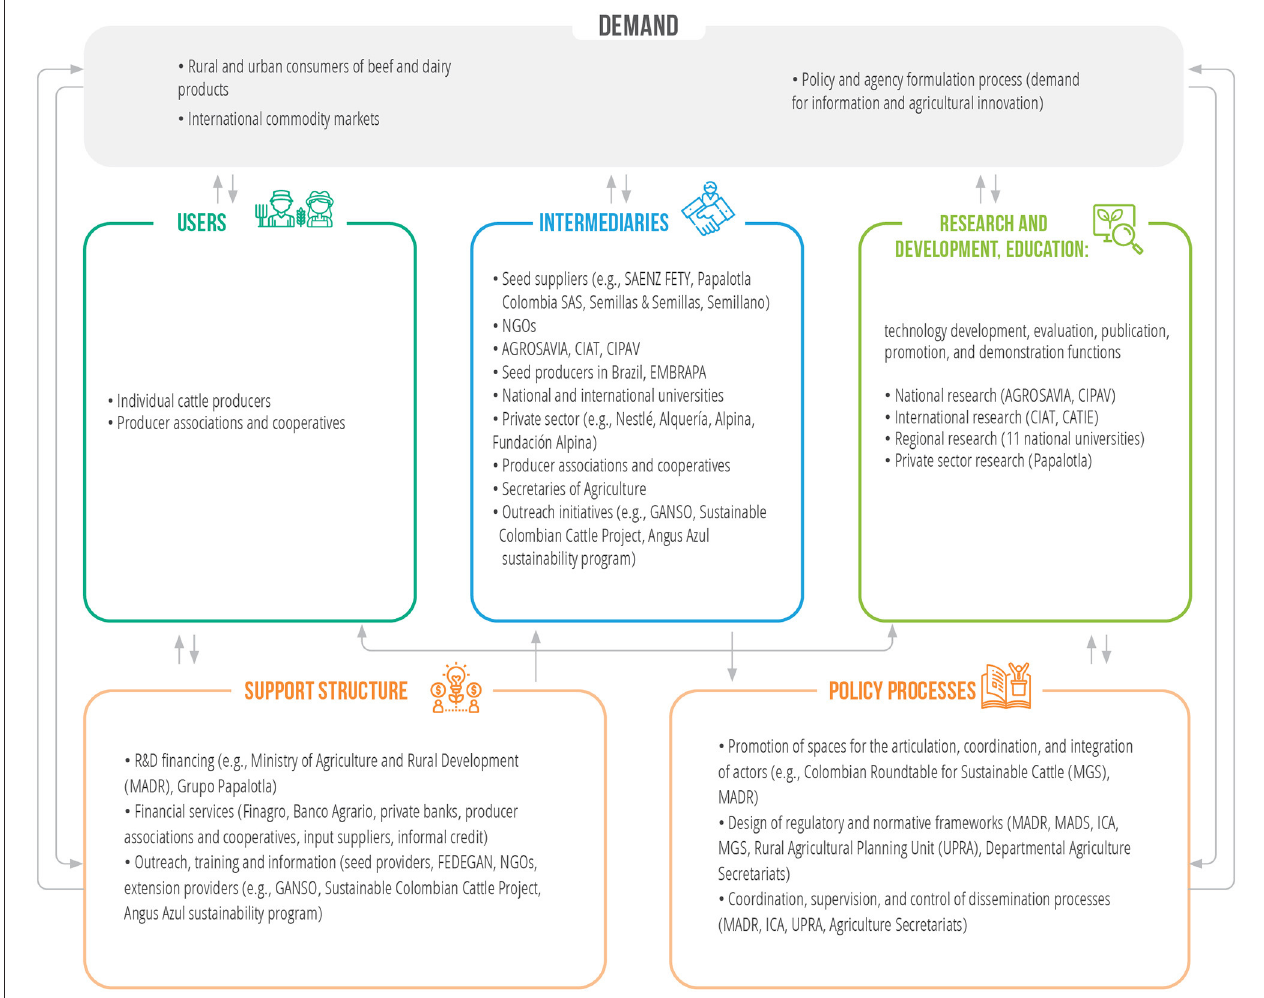
FIGURE 1 | Main agents of AIS for improved forages in